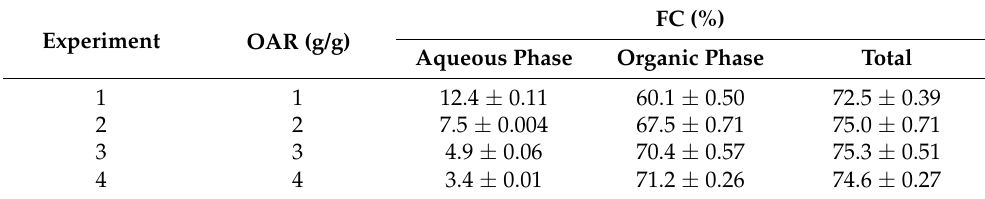
Table 1. Conversions of the potential substrates into furfural (FC) in the aqueous and organic phases obtained at 180 ◦ C, operating for 30 min with [C4mim]HSO 4 charge of 1.16 mol/L aqueous phase, using OAR in the range 1–4 g/g.